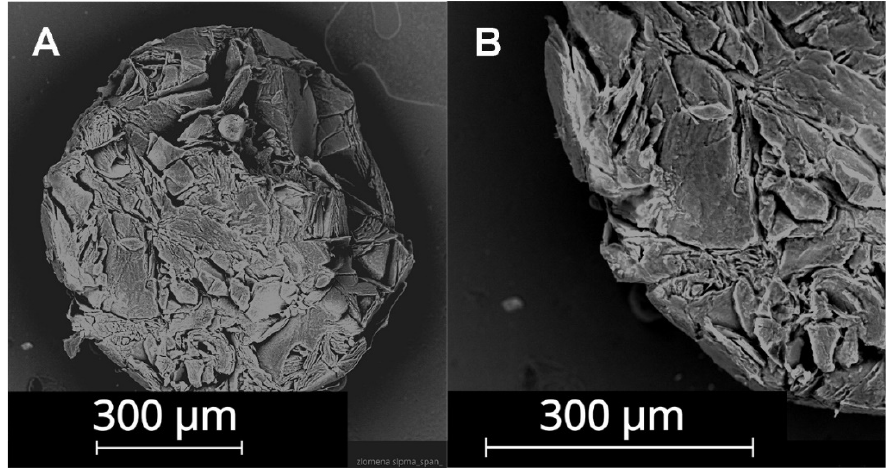
Figure 4. Structure of tetradecanol. Magnification at ( A )300×, ( B ) 550×. SEM analysis.